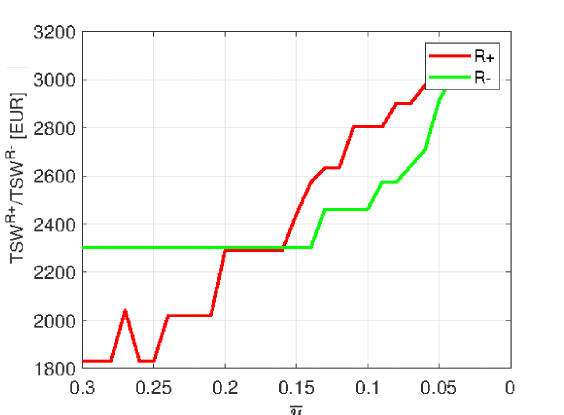
Figure 6. Total social welfare (TSW) of the reserve sub-markets as the parameter u decreases in example 2. TSW R + and TSW R − denote the total social welfare of the positive and the negative reserve market